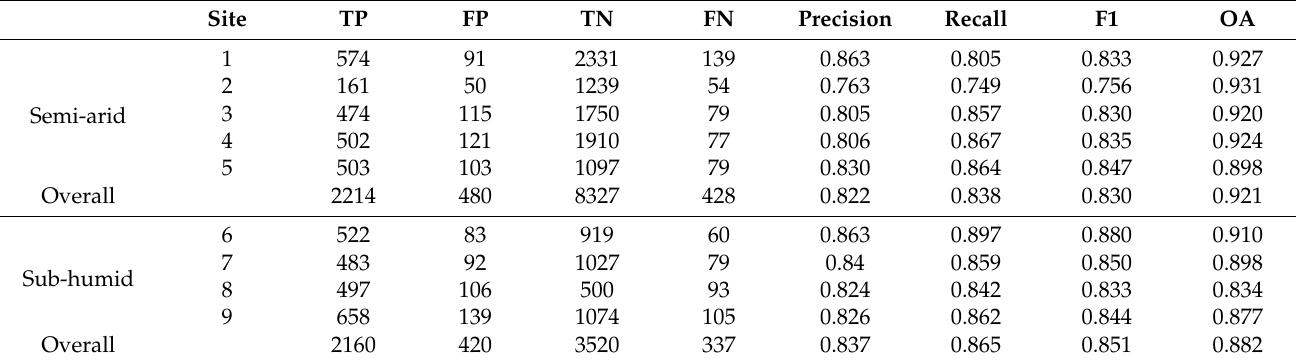
Semi-arid 2160 420 3520 Figure 9 shows an example of olive orchard maps using the region sampling approach. Figure 9d,h shows the same grids as in Figure 8b,d that uses the grid-sampling approach. Compared with the results in Figure 8, Figure 9d,h shows more false positive (red) and more false negative (blue) values, which coincide with lower precision and recall values when using the region-sampling approach.